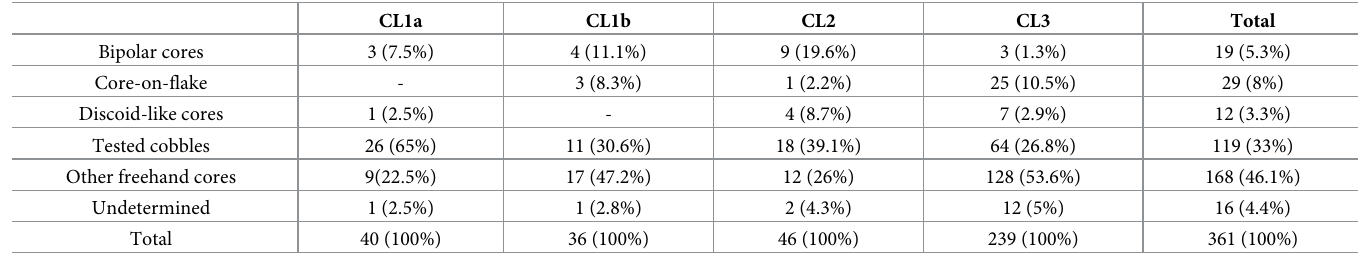
Table 7. Core types over